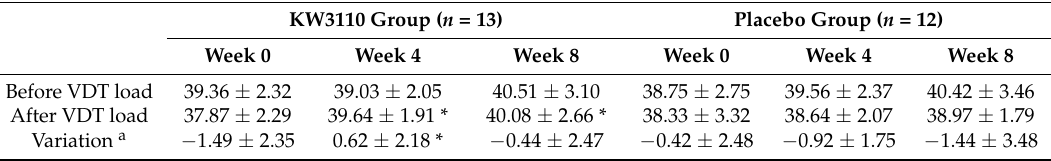
Table 5. Effects of L. paracasei KW3110 on CFFs of subjects with severe eye fatigue.